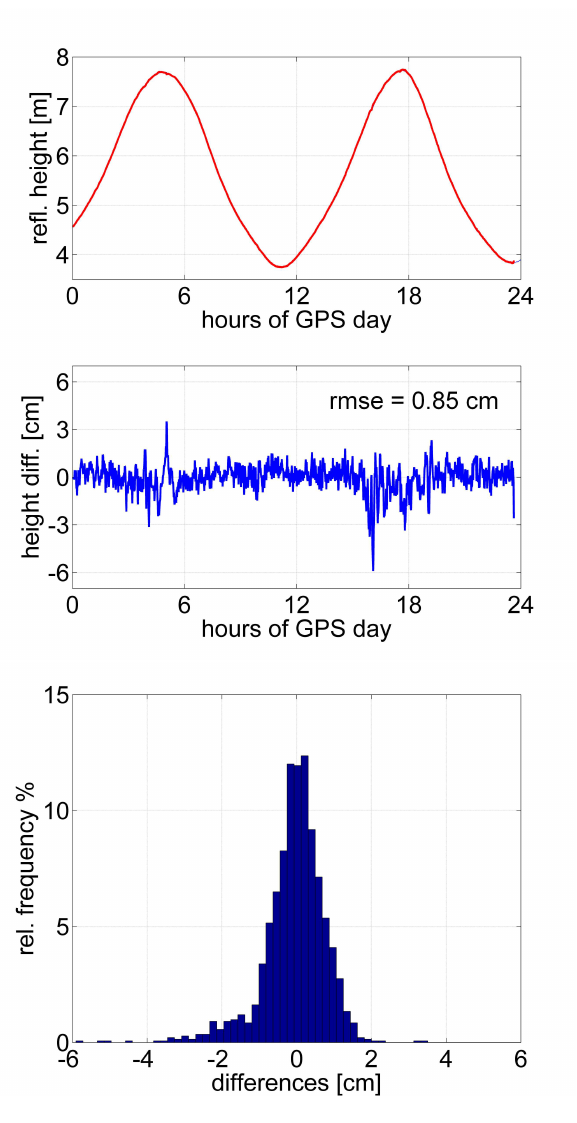
Figure 6: Resulting reflector heights. Top panels: calculated and estimated reflector height, differences to simulated values in a time window. Bottom panel: histogram of the